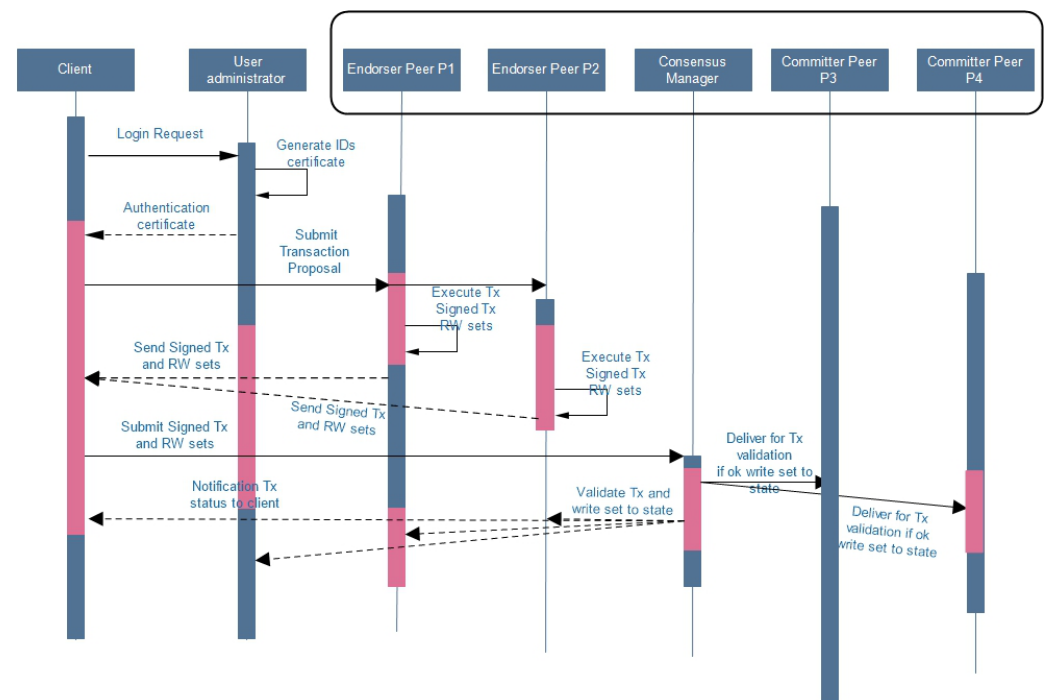
Figure 4. Transaction execution procedure in DSCMR